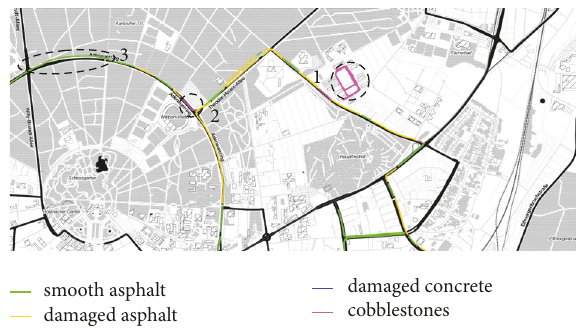
Figure 10: Material classification of cobblestone and road segments in urban